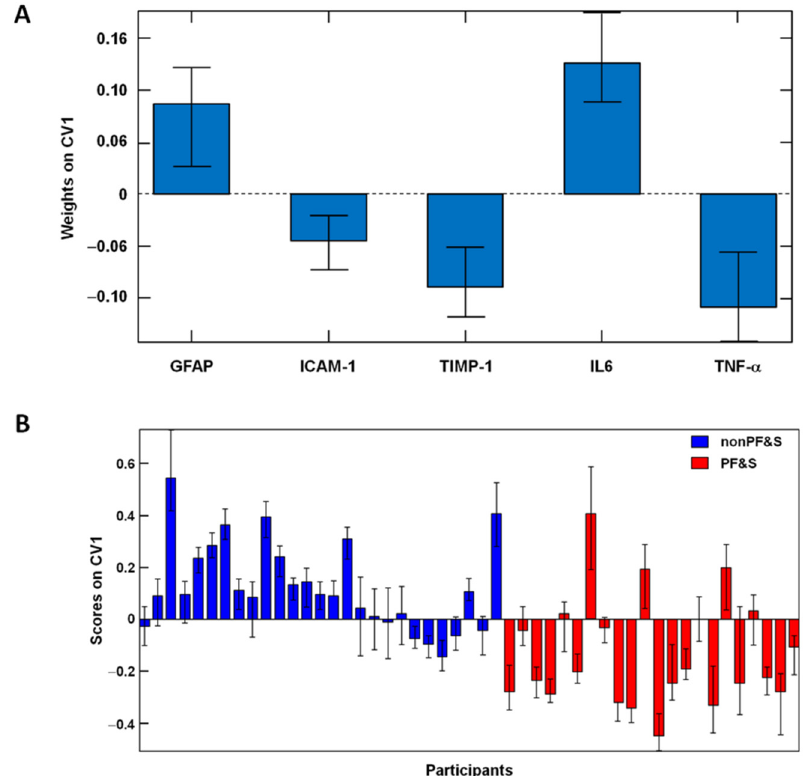
Figure 3. Results of Partial Least Squares Discriminant Analysis on the Reduced Subset of Relevant Circulating Markers. ( A ) Variable weights along the only canonical variate (CV) of the model. Results indicate that all the five selected markers significantly contribute to the discrimination between participants with physical frailty and sarcopenia (PF&S) and nonPF&S controls. ( B ) Double cross-validation scores with 95% confidence intervals of outer loop samples along the only canonical variate of the model. Abbreviations: GFAP, glial fibrillary acidic protein; ICAM-1, intercellular adhesion molecule 1; IL, interleukin; TIMP-1, tissue inhibitor matrix metalloproteinase 1; TNF- α , tumor necrosis factor- α